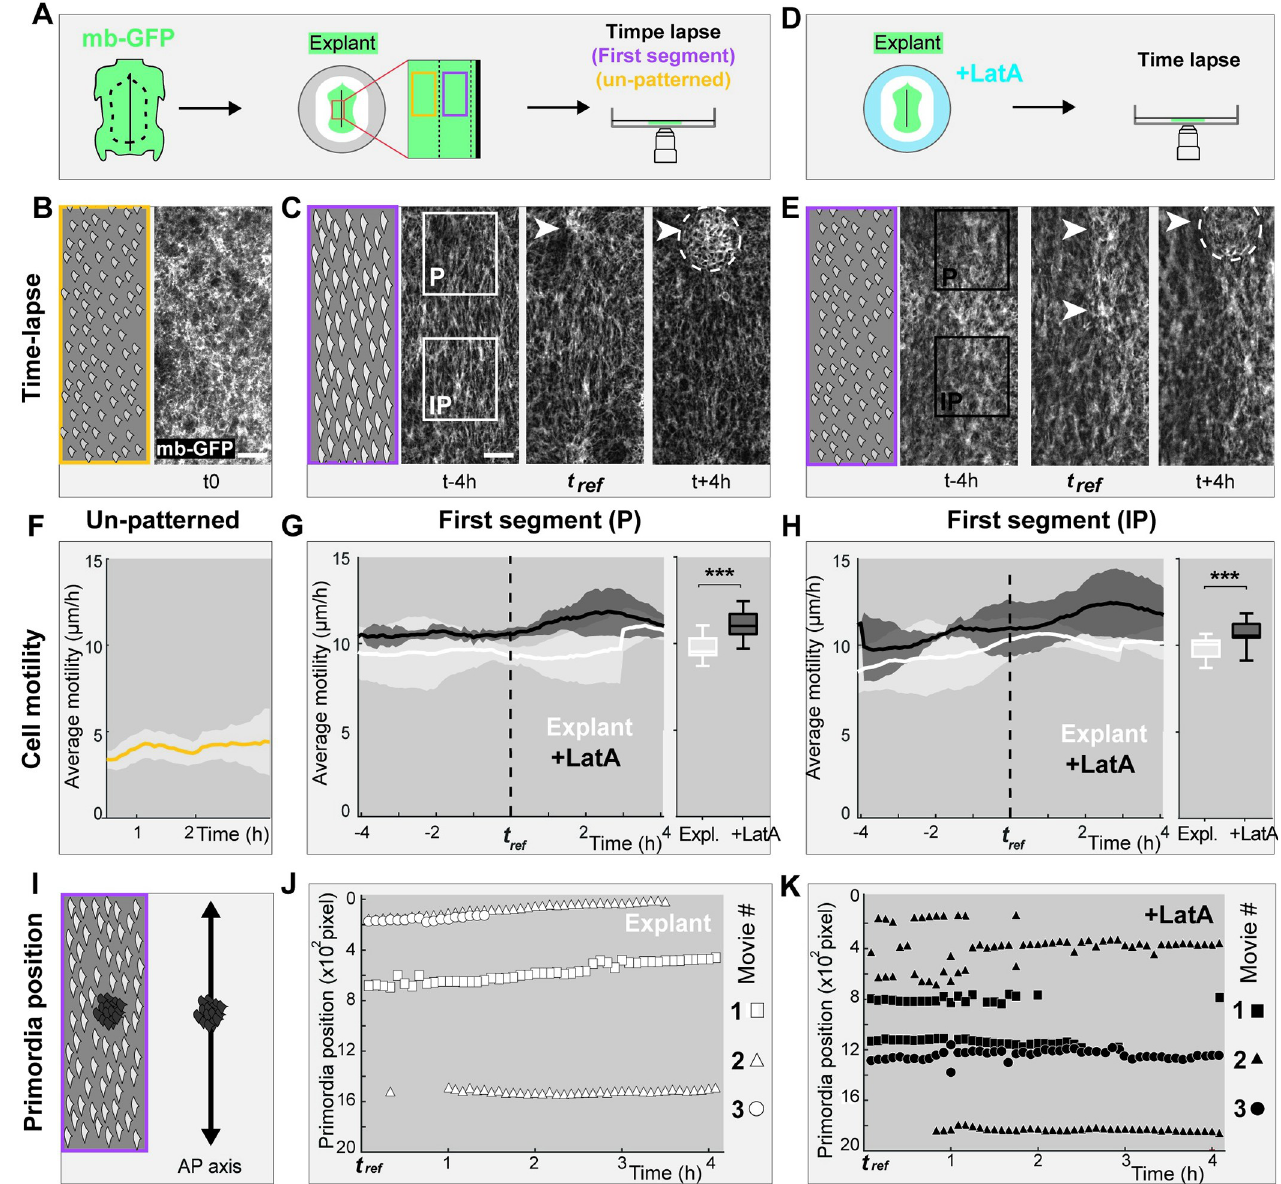
Fig 7. Cell shape anisotropy and motility stabilize nascent primordia positioning. (A) To perform time-lapse experiments, dorsal skin explants of membrane-GFP (mb-GFP) Japanese quails were placed dermal side down on nitrocellulose filters for confocal imaging (see Materials and methods). Movies focused on un-patterned regions (in yellow) or the first competent segment (in purple). (B) Snapshot at t0 of a time-lapse confocal movie in the un-patterned region and corresponding schematic. (C) Snapshots of a confocal movie in the first-formed segment 4 h before, at, and after t ref recorded at dermal level show the formation of a primordium (white arrow). A schematic shows anisotropic cells at t-4h. White squared lines mark the position of automatically detected putative primordium (P) and inter-primordium (IP) areas. White dotted lines and arrowheads show a nascent primordium. (D, E) The same experiments were performed after Latrunculin A treatment (LatA; black squared lines mark P and IP areas; white dotted lines and arrowheads show 2 nascent primordia). Scale bar: 50 μ m. (F) Quantifications of average cell motility (in μ m/h) during 2 h in the un-patterned region showed it is stable through time. (G, H) Quantifications of average cell motility (in μ m/h) in hours to t ref , marked with a line or averaged in box plots in IP and P regions showed that cell motility increases upon drug treatment (in black) compared to control conditions (in white; unpaired 2-tailed t test, p < 0.0001 both for IP and P). (I, J) We tracked the antero-posterior position (in pixel × 10 2 ) of software-detected primordia within competent segments. Graphical representations of primordia position at each time point of 3 independent movies (shown by a white shape code) showed that in un-treated explants, emerging primordia maintained stable positions. In movie #2 (triangles), 2 spaced-out primordia emerge. (K) In Latrunculin A-treated explants, the reduction of cell shape anisotropy caused imprecision in nascent primordia position, which can emerge closely and fuse together. This is seen in movie #2 (triangles), and #3 (dots). The data underlying this figure can be found at 10.5281/zenodo.7006365. Scale bars: 50 μ m. Error bars: standard deviation, stars show significance of statistical tests.